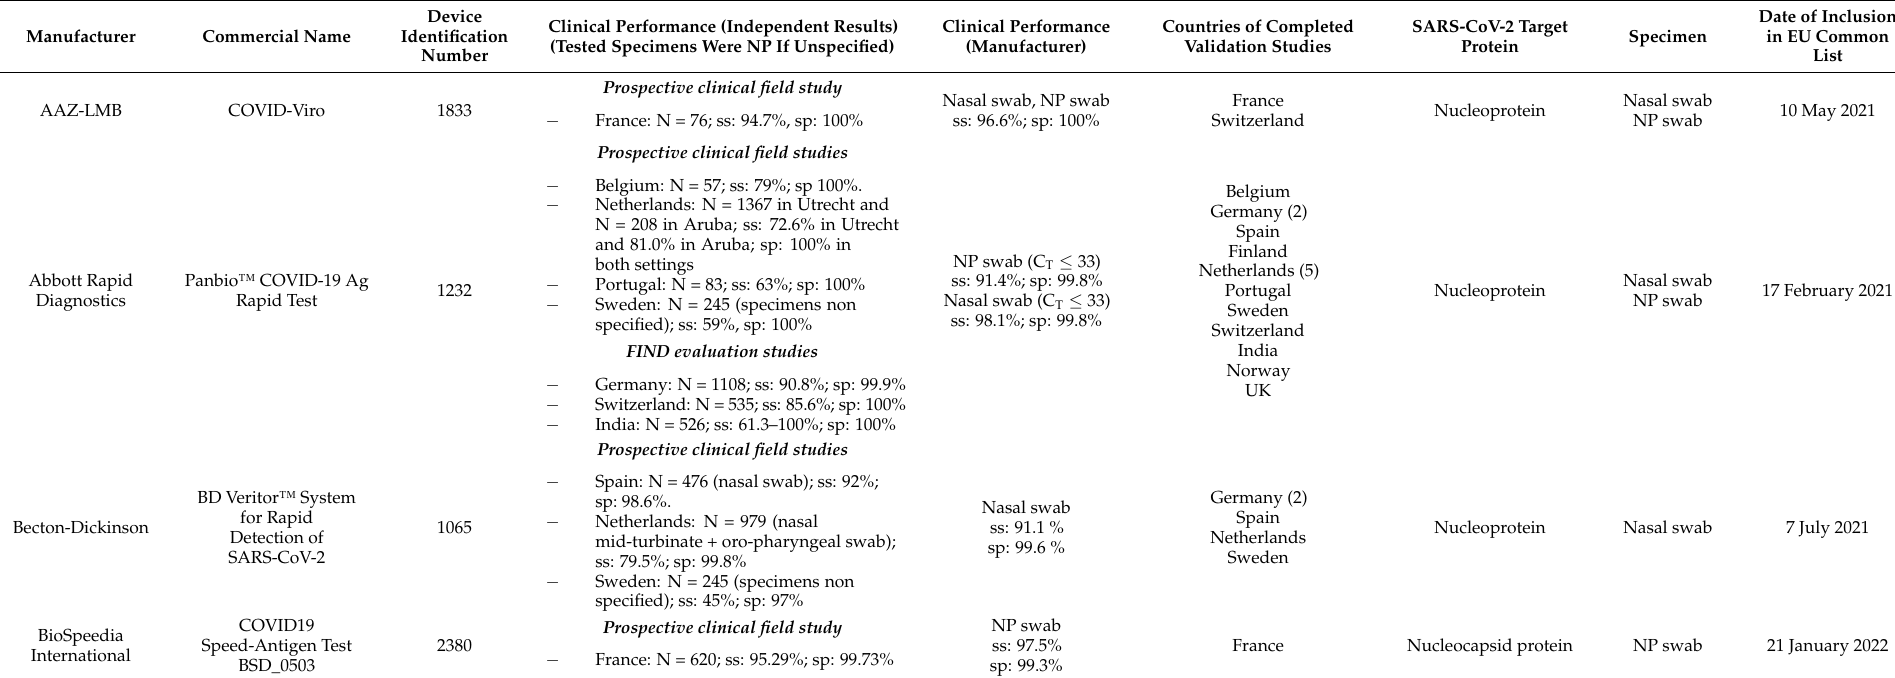
Table 1. Characteristics of the four tested RLFTs, which were all registered on the European Union (EU) common list